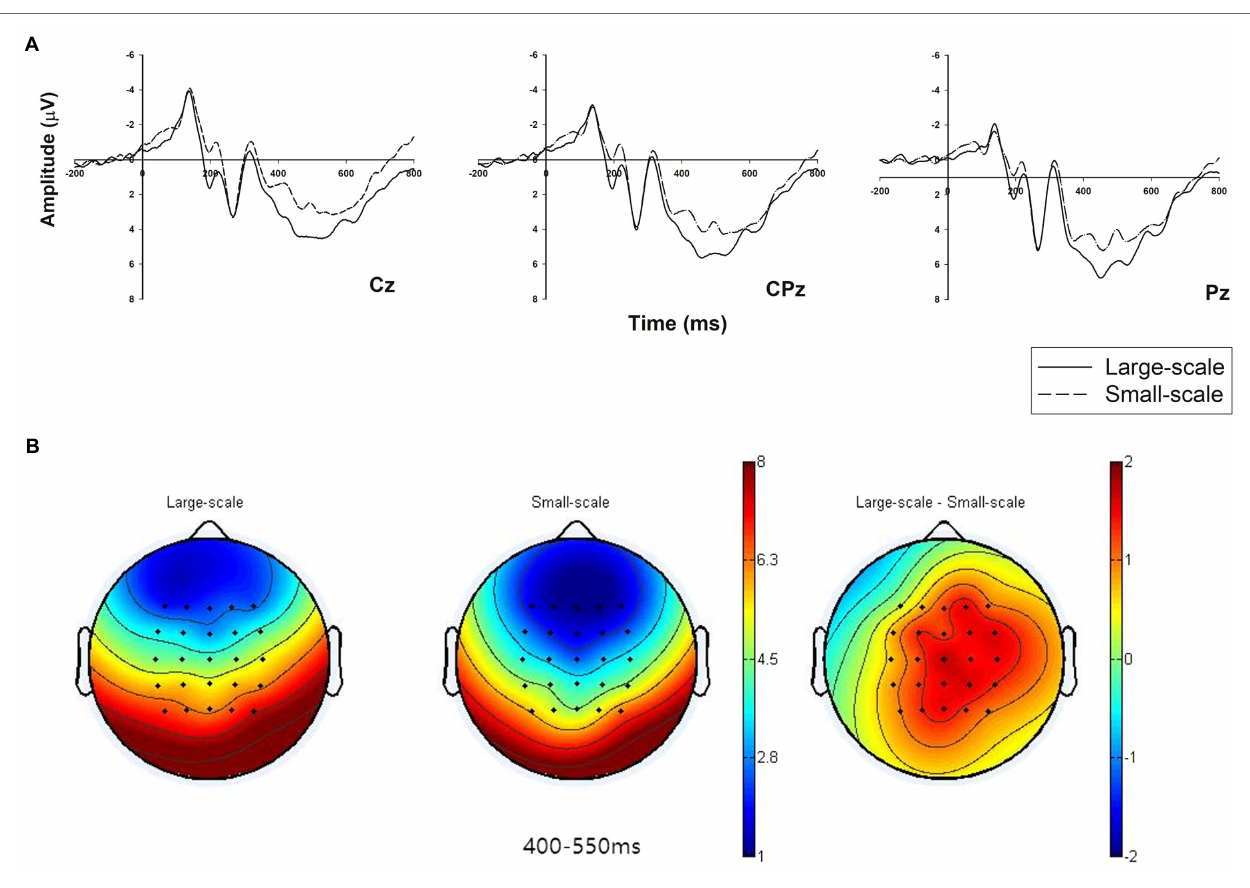
FIGURE 4 | Grand-averaged event-related potential (ERP) waveforms of LPP in the central-to-parietal region with three electrodes and related brain topography. (A) The LPP amplitude comparison of the two conditions of 3PL guaranteeing firms (large-scale vs. small-scale) at representative electrodes (Cz, CPz, and Pz). (B) The brain topography of the two conditions and a contrast at the LPP time window of 400–550